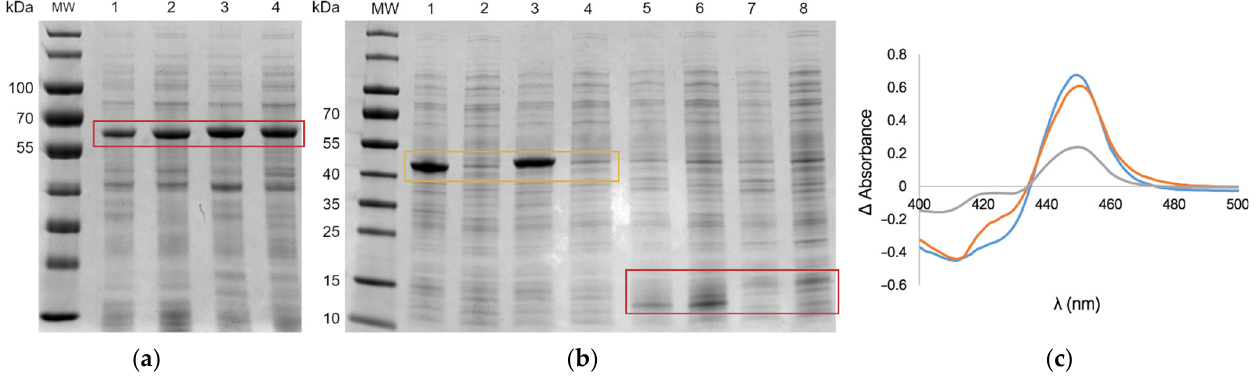
Figure 1. SDS ‐ PAGE analysis of A. dieselolei B ‐ 5 proteins expressed in E. coli BL21 ‐ Gold (DE3). ( a ) CYP153A71 expressed from pET22b(+) (lanes 1–2) and pET28b(+) (lanes 3–4); lanes 1 and 3 represent the total crude cell lysate fraction and lanes 2 and 4 the soluble protein fractions (CFEs); ( b ) natural redox partners of CYP153A71; FdR ‐ A71 (lanes 1–4) and Fdx ‐ A71 (lanes 5–8). Lanes 1, 2, 5, and 6 represent redox partners expressed from pET22b(+), and lanes 3, 4, 7, and 8 are redox partners ex ‐ pressed from pET28b(+). Lanes 1, 3, 5, and 7 represent the crude cell lysate fractions and lanes 2, 4, 6, and 8 represent the soluble protein fractions (CFEs). CYP153A71 (54/56 kDa); FdR ‐ A71 (42/44 kDa); and Fdx ‐ A71 (12/14 kDa). MW: PageRuler prestained protein ladder; ( c ) CO ‐ difference spectra obtained using the cell ‐ free extract of CYP153A71 (blue) compared to CYP153A6 (orange) and CYP153A13 (gray).